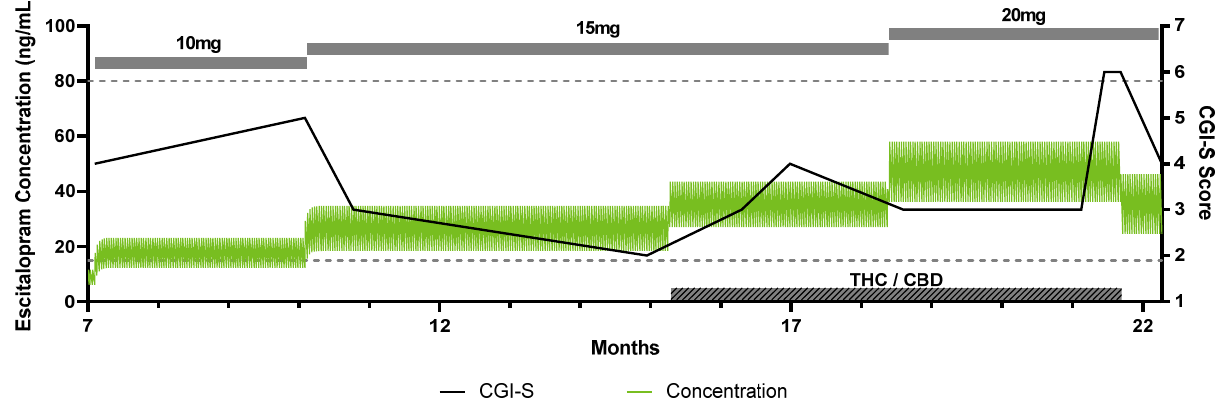
Figure 3. Time course with simulation of escitalopram plasma concentrations in adolescent CYP2C19 normal metabolizer taking low-dose over-the-counter CBD. This patient was being treated with escitalopram, treatment was well-controlled at 10 mg daily and increased to 15 mg daily at month 10 with worsening anxiety. The dose was increased to 20 mg daily at 18.5 months when anxiety again worsened. The green line indicates the simulated escitalopram plasma concentration plotted on the left y-axis. The black line indicates the CGI-S score, plotted on the right y-axis. The gray boxes indicate the escitalopram daily dose. The hashed gray box indicates when the patient was using the THC/CBD. The dashed lines indicate the upper and lower therapeutic reference range (15–80 ng/mL) in adults [46]. Abbreviations: CBD, cannabidiol; OTC, over-the-counter, CGI-S, Clinical Global Impression Scale-Severity of Illness, THC, tetrahydrocannabinol.